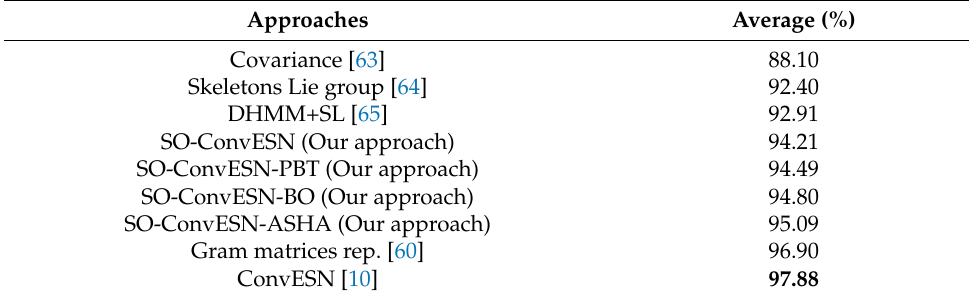
Table 5. Recognition accuracy on cross-subject test of the MSRA3D dataset.